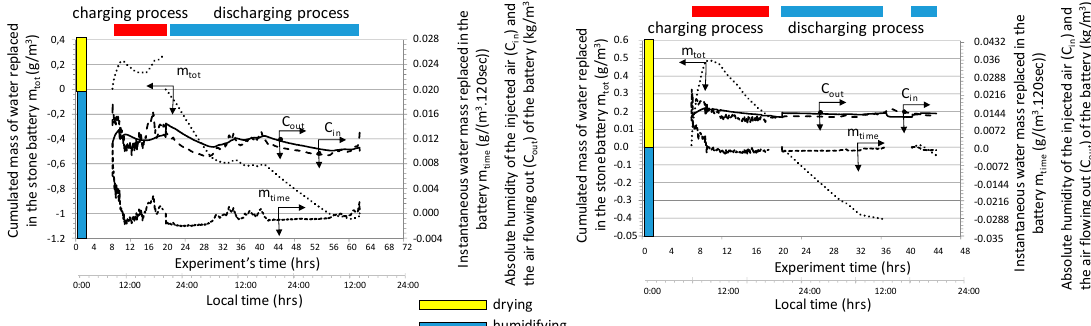
Figure 11. Change in the concentration of water vapor in the air forced in and flowing out of the bed, as well as the instantaneous and total water flow exchanged between the accumulator and the tunnel interior.